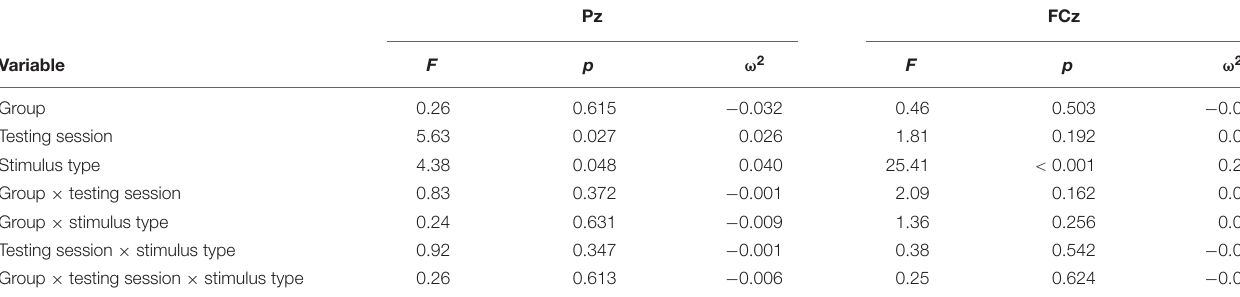
TABLE 7 | Results of P3b latency at Pz and FCz repeated measures ANOVA.